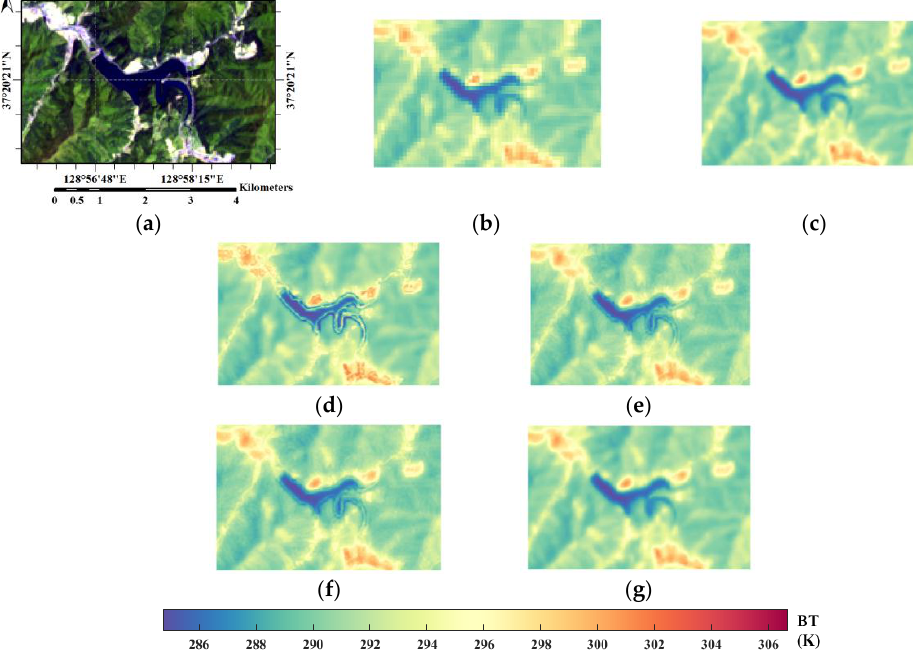
Figure 8. Disaggregated brightness temperature results at subset C: ( a ) SWIR2-SWIR1-Blue composite image; ( b ) Original BT image; ( c ) Distributed BT image; ( d ) DisTrad method; ( e ) TsHARP method; ( f ) LMS method; ( g ) Proposed GF method.